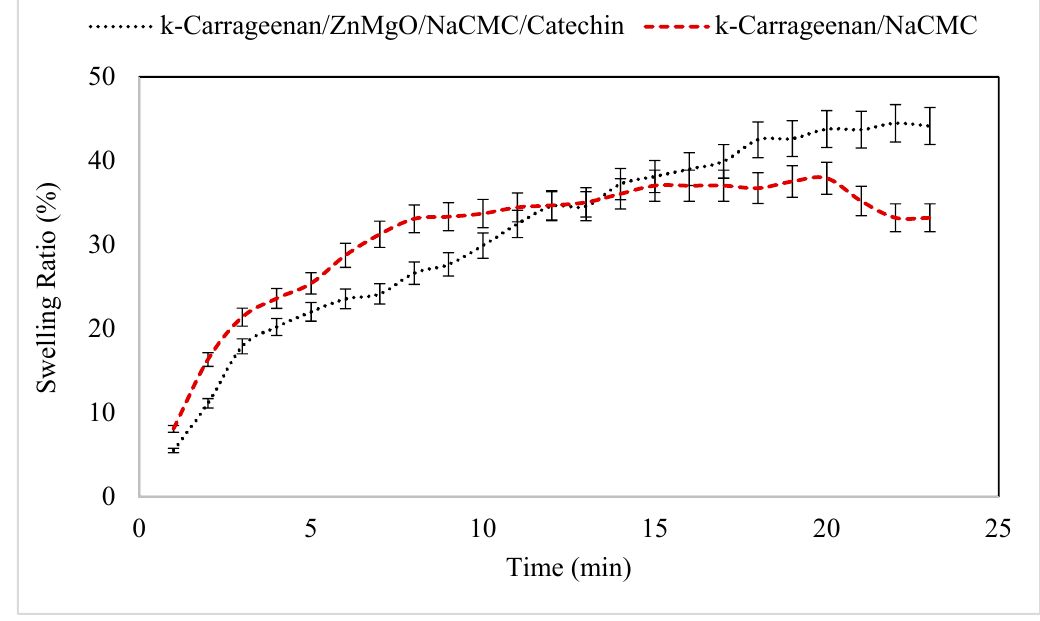
Figure 9. Swelling capacity of the two various composite (of κ -Carrageenan / Mg 0.99 Zn 0.01 O / NaCMC / Catechin and of κ -Carrageenan / NaCMC) hydrogel in distilled water .